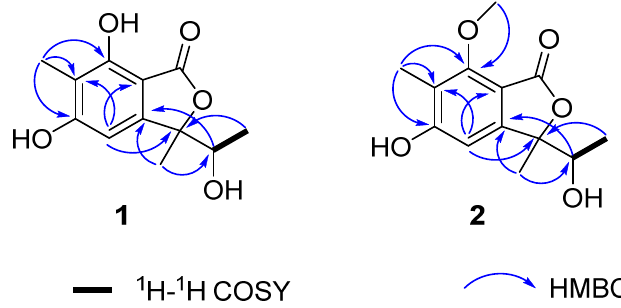
Figure 2. 1 H- 1 H COSY and key HMBC correlations of 1 and 2 . Table 1. 1 H (500 MHz) and 13 C NMR (125 MHz) spectral data of 1 and 2 ( δ in ppm, J in Hz).